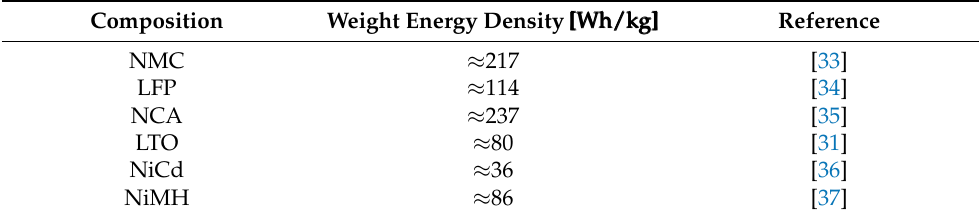
Table 4. Common rechargeable batteries with their weight energy density. The first four are lithium- based, while the latter two are nickel